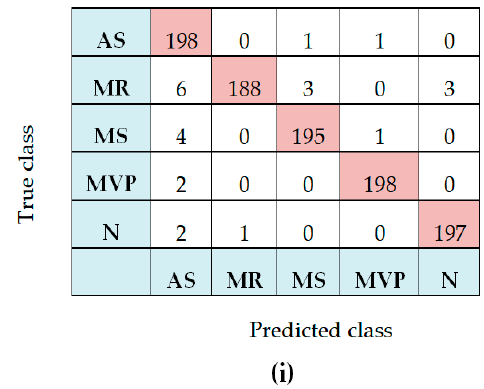
Figure 6. ( a ) Confusion matrix for MFCCs Features and Centroid displacement based KNN classifier; ( b ) Confusion matrix for DWT Features and Centroid displacement based KNN classifier; ( c ) Confusion matrix for MFCCs plus DWT Features and Centroid displacement based KNN classifier; ( d ) Confusion matrix for MFCCs Features and DNN classifier; ( e ) Confusion matrix for DWT Features and DNN classifier; ( f ) Confusion matrix for MFCCs plus DWT Features and DNN classifier; ( g ) Confusion matrix